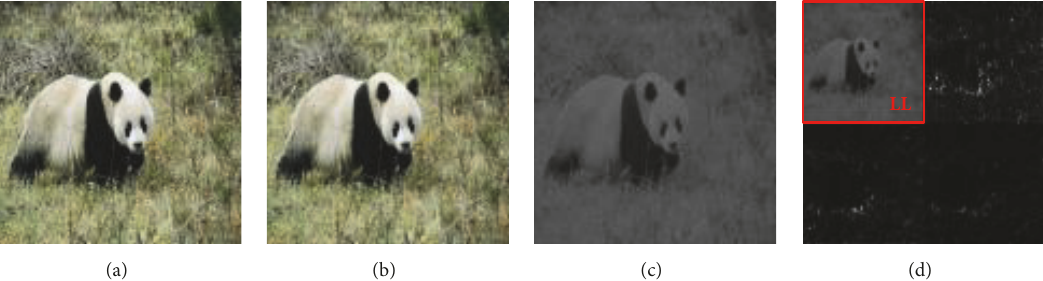
Figure 1: Image preprocessing results for each step. (a) Original image, (b) Gaussian low-pass filtering, (c) LAB conversion, and (d) IntWT